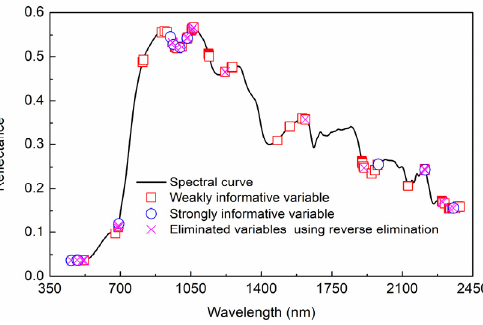
Figure 5. Selection of characteristic wavelength using IRIV based on rain-shelter cultivation.